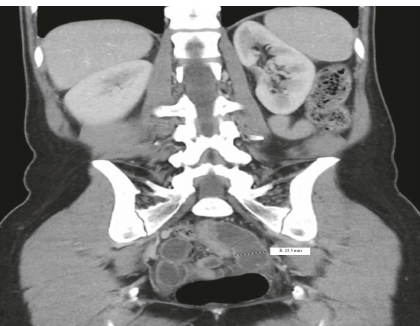
Figure 2: Coronal CT image of the small bowel extending into the vaginal. Normal thickness is less than 30